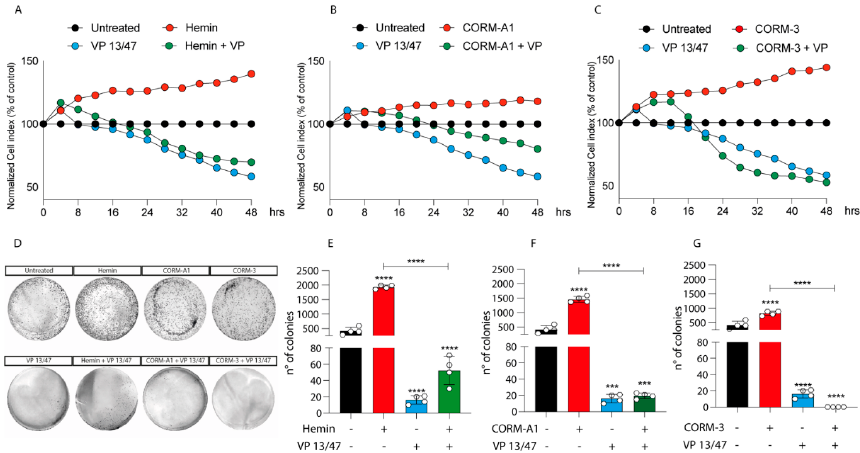
Figure 2. Hemin, CORM-A1, and CORM-3 increase 92.1 proliferation and number of colonies. ( A ) Hemin (10 µ M), ( B ) CORM-A1 (25 µ M), and ( C ) CORM-3 (25 µ M) enhance UM proliferation. xCELLigence assay monitoring real-time 92.1 cell proliferation upon Hemin, CORM-A1, and CORM-3 supplementation, showing an enhanced cellular proliferation already 16, 24, and 20 h post-treatment, respectively Interestingly, VP 13/47 addition (50 µ M) disrupts hemin-, CORM-A1-, and CORM-3-, induced proliferation. Each line is expressing the average of four different experiments (mean ±